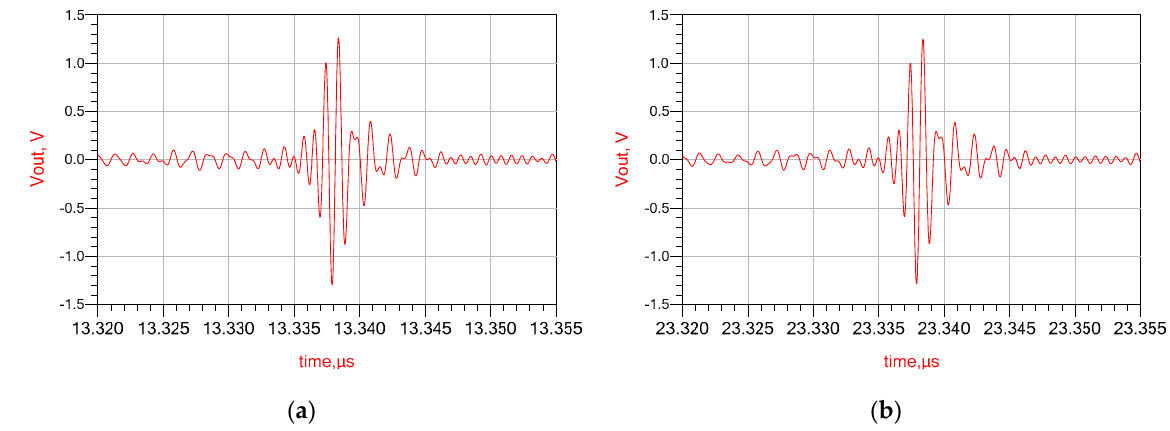
Figure 6. Single pulse shape of the input frequency of 1.9 GHz. ( a ) is the pulse appearing at 13.338 µs from the classical two-channel CTS structure; ( b ) is the pulse appearing at the next period (23.338 µs) from the TDS M-C arrangement.